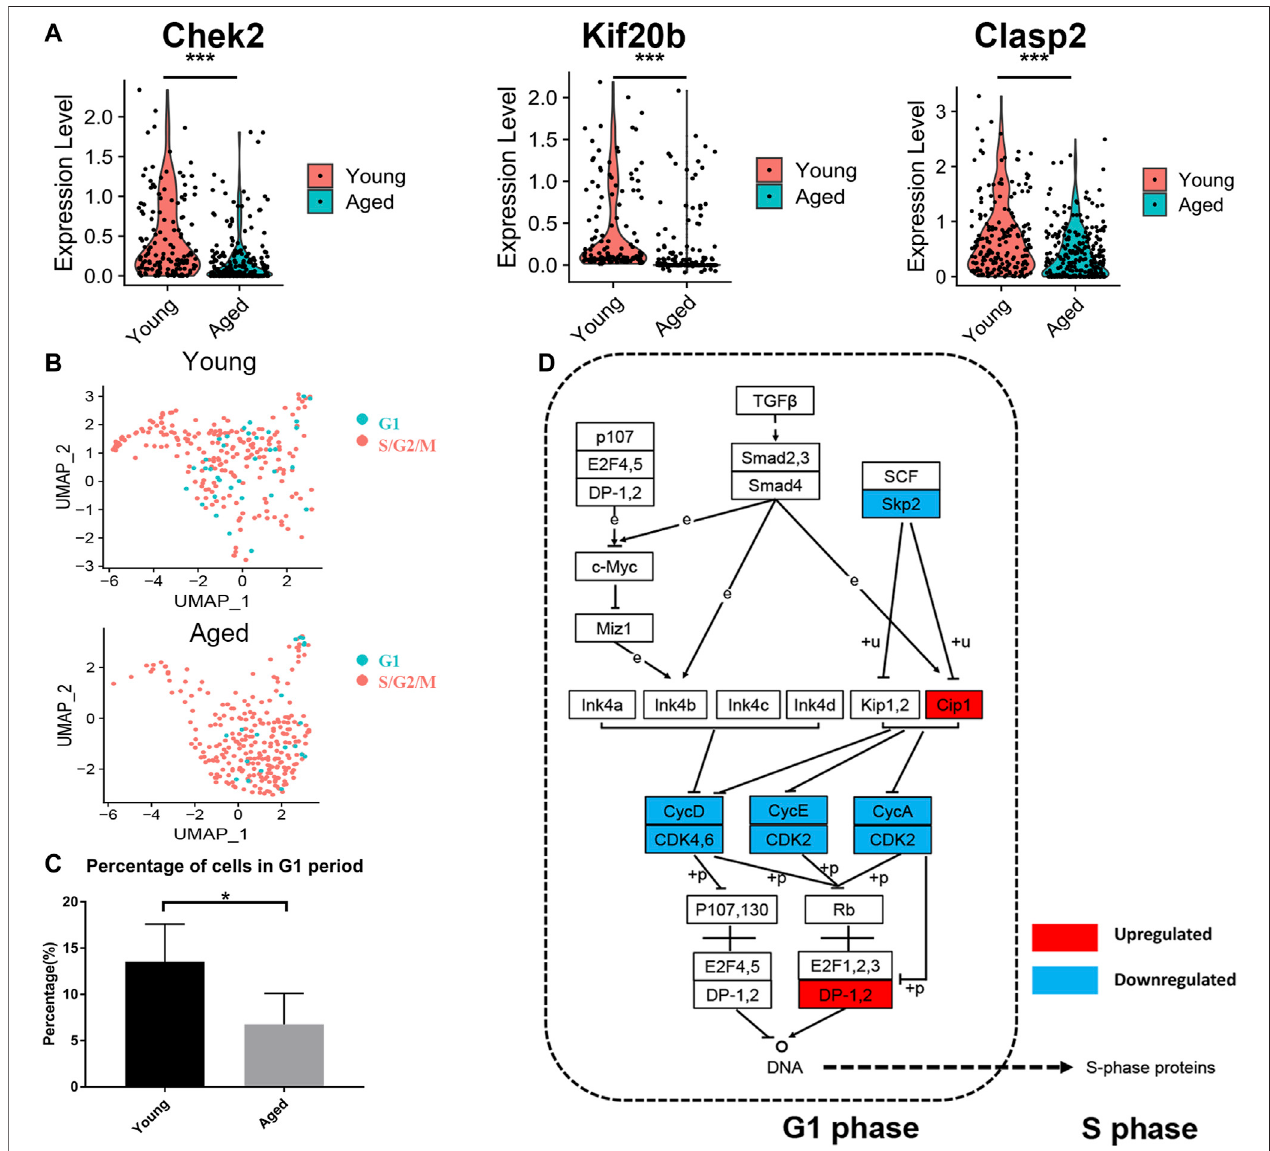
FIGURE4| Cell cycle analysisofHSCs. (A) Violin plotshowingthe expression levels ofcell cycle-associated genes(Chek2,Kif20band Clasp2)in young and aged HSCs. (B) UMAP plot for young and aged HSCs. (C) Histogram of cell frequency in the G1 cluster. Data are presented as the mean ± SEM. * p < 0.05. (D) Cell cycle pathway diagram showing alterations in signaling pathway activity. Downregulation of the Skp2-induced signaling pathway (Skp2 → Cip1 → CycA/CDK2 → DP-1) promoted the transition from G1 phase to S phase. Upregulated genes are marked in red and downregulated genes are marked in blue.